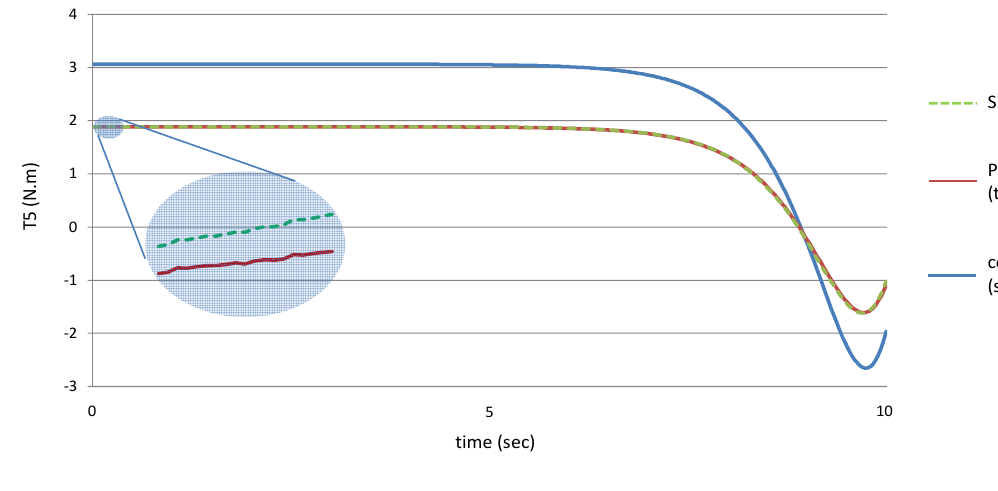
Figure 25. The torque of the sixth joint angle.